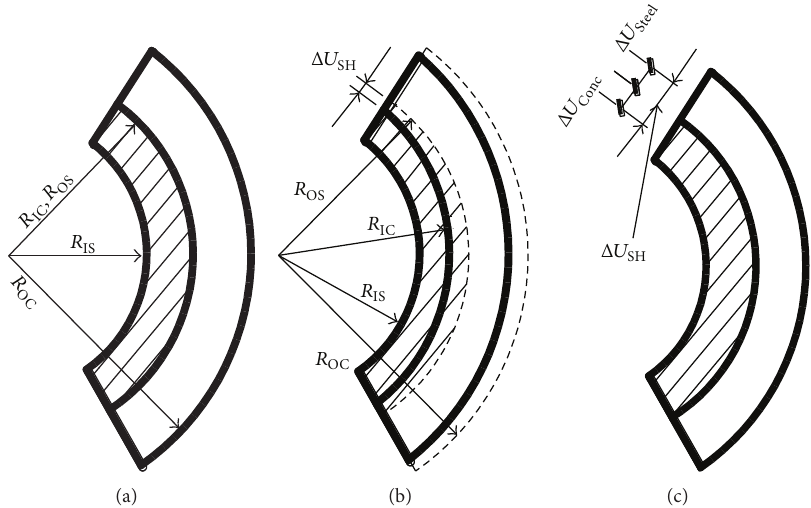
Figure 10: Illustration of the compatible deformation between the steel ring and the mortar ring. (a) Before mortar shrinkage; (b) removing constraint and allowing the mortar to shrink; (c) final geometry satisfying boundary condition